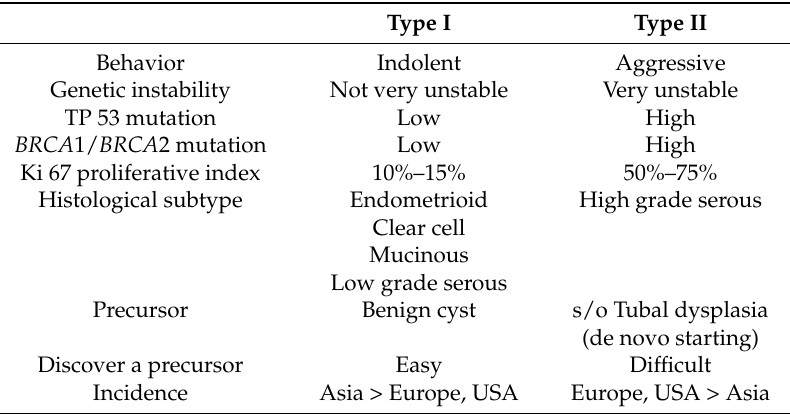
Table 1. Characteristics of two types of ovarian